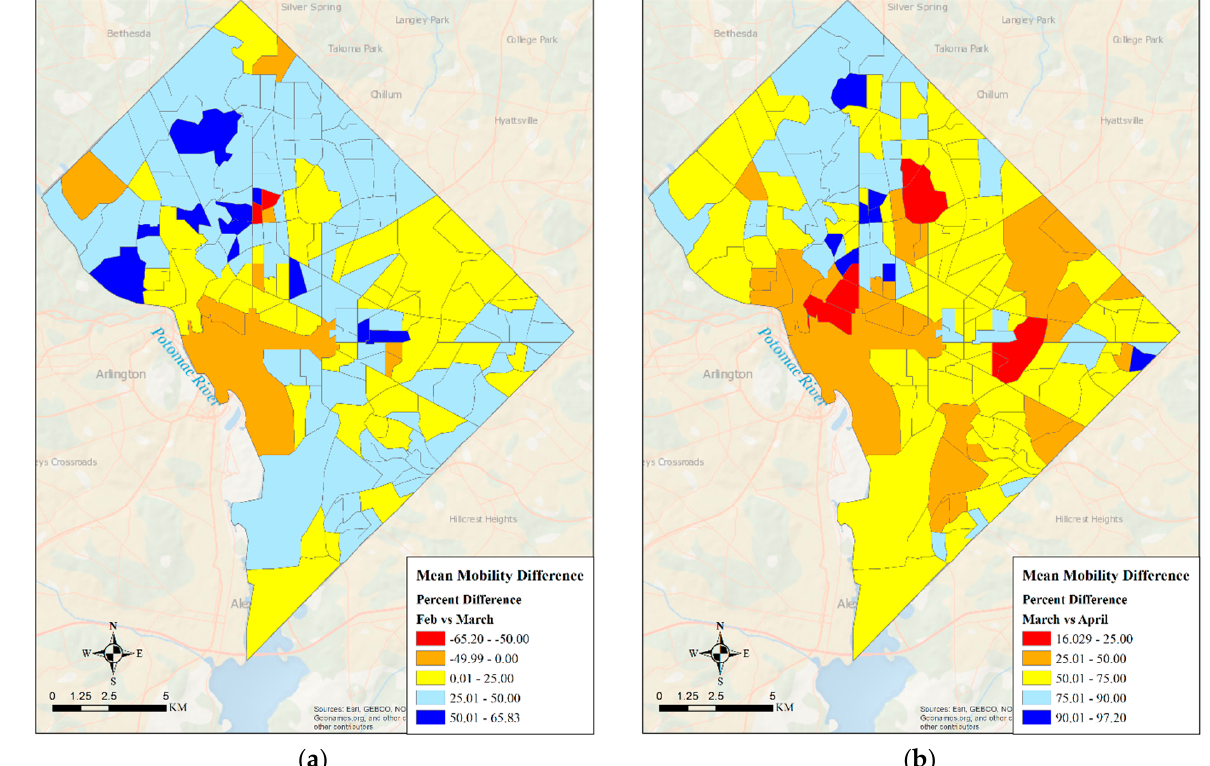
Figure 10. Mean mobility percentage difference in Washington DC between February and March ( a ) and between March and April ( b ).